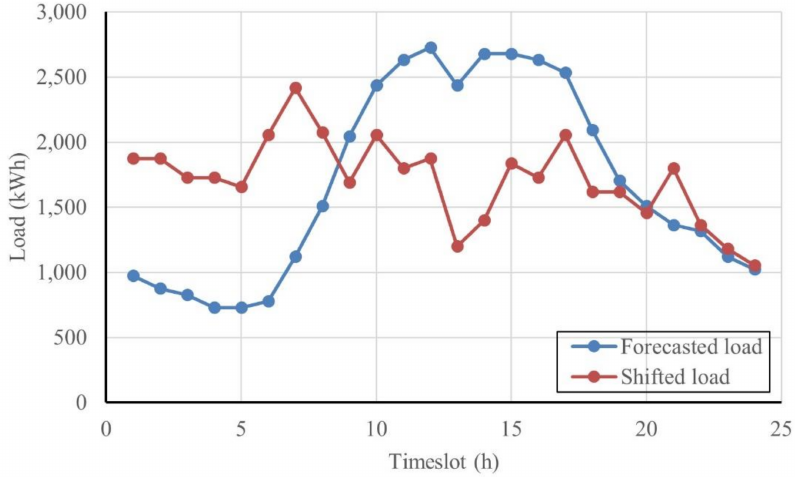
Figure 22. Hourly industrial load before and after DSM using the centralized algorithm